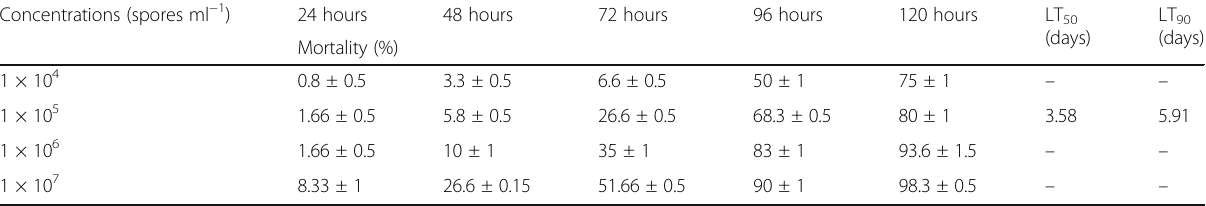
Table 2 Efficacy of the B. bassiana strain (Y-F_ITS1) against fourth instar larvae of G. mellonella Concentrations (spores ml − 1